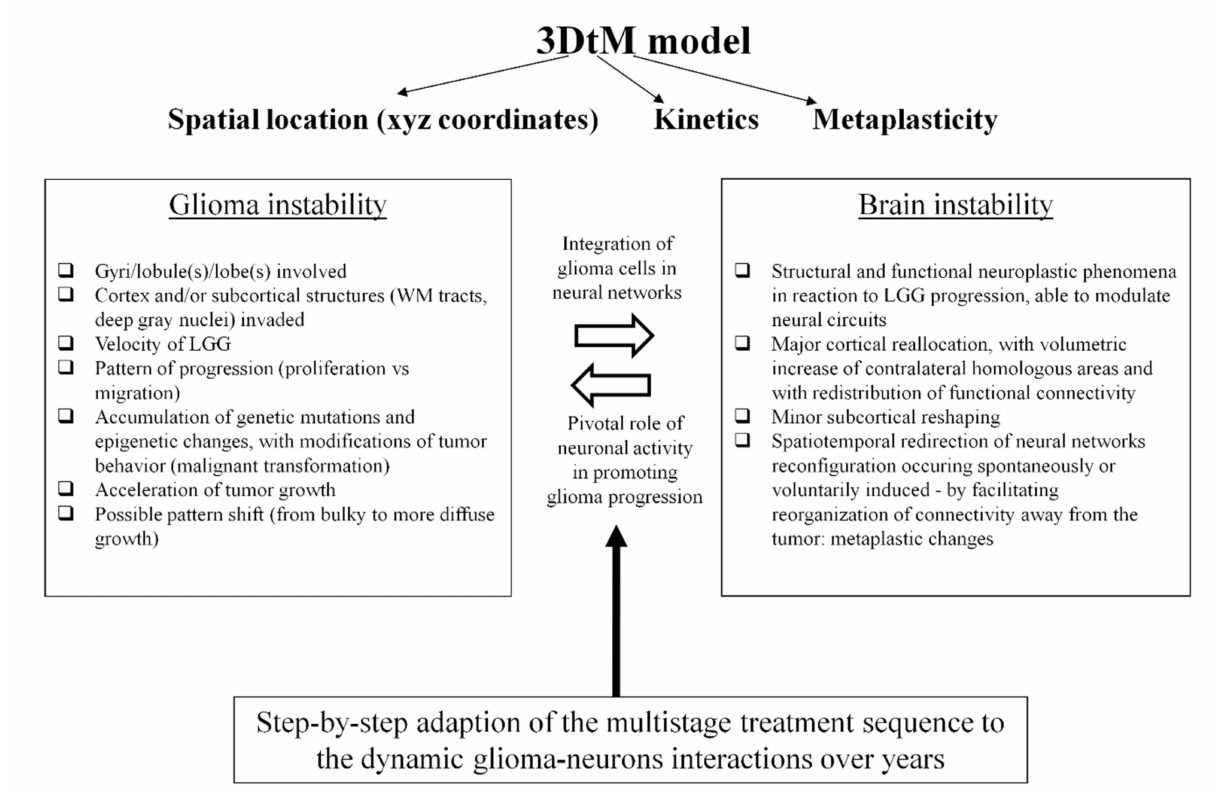
Figure 2. Modeling the continuously changing interplay between LGG progression and brain reactional reconfiguration to tailor the multistep therapeutic